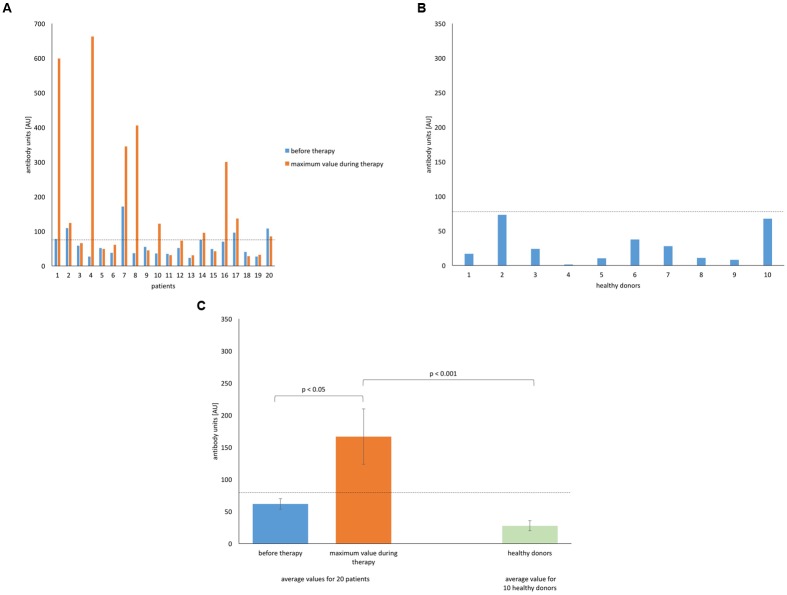
Levels of IgG anti-MS-1 phage antibodies in human sera. (A) Patients (n = 20) treated with S. aureus MS-1 phage cocktail. (B) Healthy (n = 10) donors. (C) Average values for patients treated with S. aureus MS-1 phage cocktail and healthy donors. Average values are plotted with the standard error (SE) indicated by the error bars. Median value for the group of patients during treatment is marked on each graph by a horizontal dotted line.